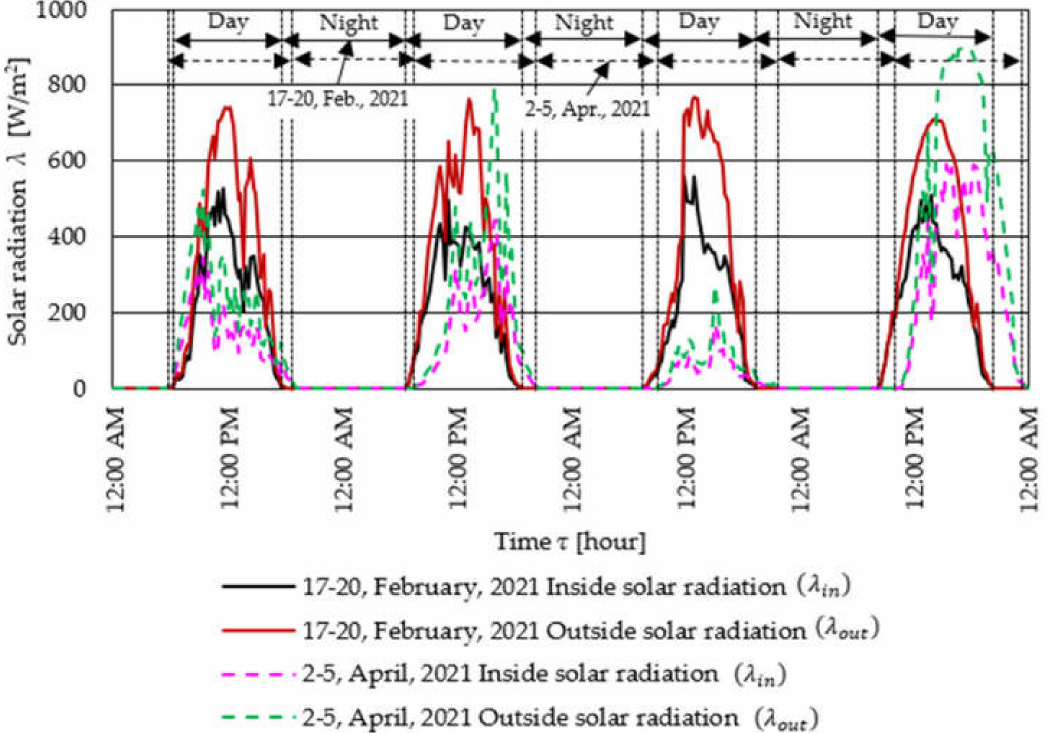
Figure 6. The comparison of solar radiation inside and outside the greenhouse at different times.